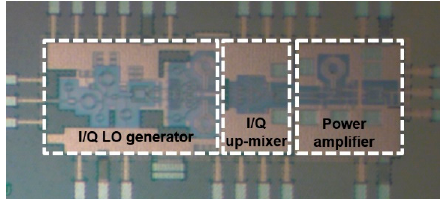
Figure 10. Chip photograph of the fabricated 24-GHz transmitter.